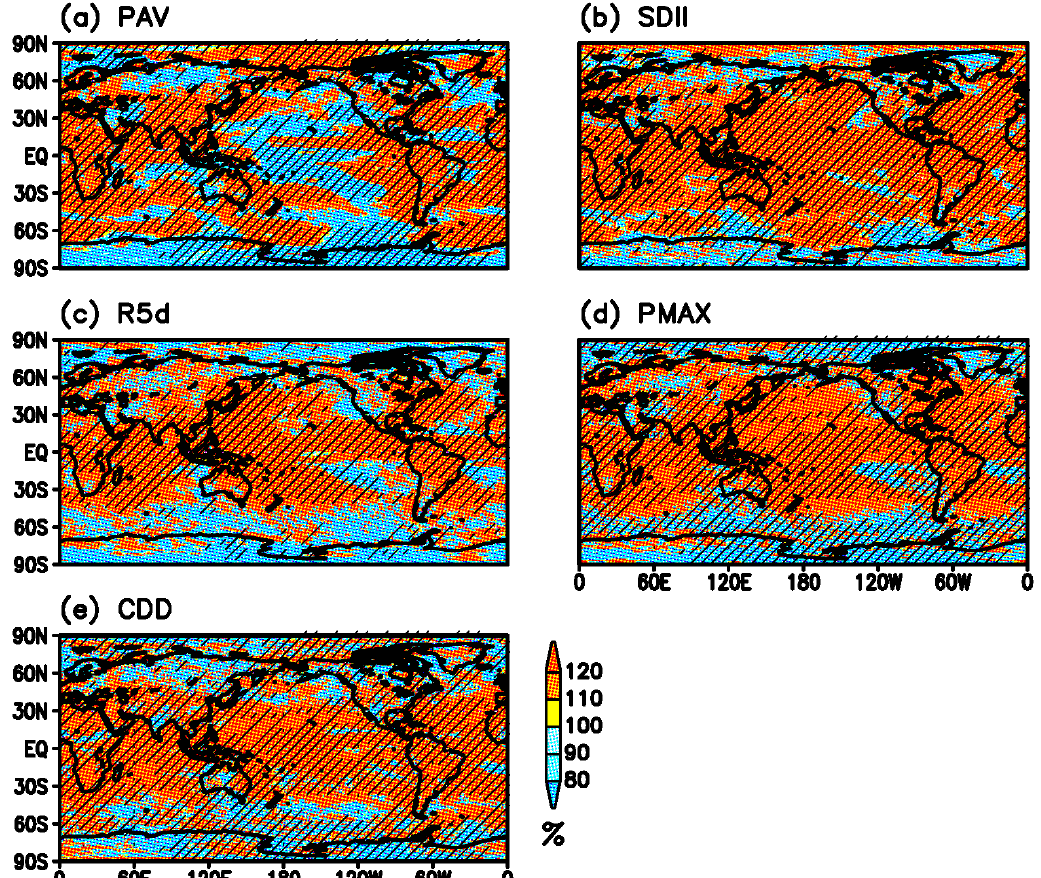
Figure 8. Ratio (%) of the variance by the cumulus convection scheme to the variance by SST. The ANOVA is applied for future changes in precipitation indices (Table 3). Hatched regions show the ratio above the 95% significance level. ( a ) PAV; ( b ) SDII; ( c ) R5d; ( d ) PMAX; ( e ) CDD. (a) is the same as Figure 7g.